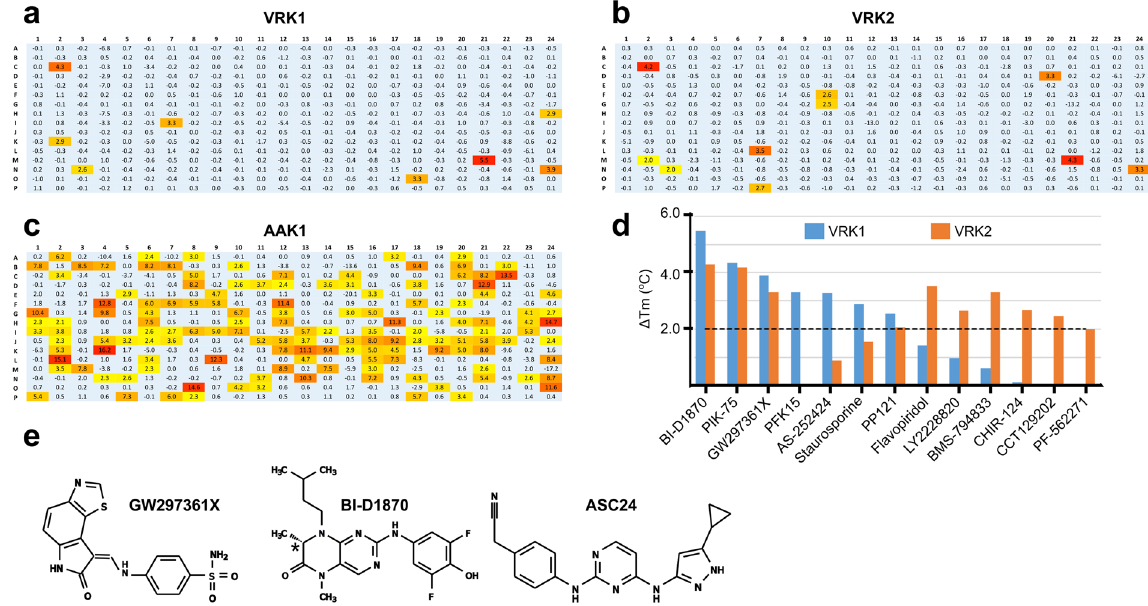
Figure 2. DSF screening identified few hit compounds for active VRKs. Heat maps showing DSF screening data for ( a ) VRK1, ( b ) VRK2 and ( c ) AAK1 (included for comparison) versus a 378-compound library of cell-permeable, bioactive kinase inhibitors. The color scheme is the same as in Fig. 1a. Panels indicate rows (x-axis) and lines (y-axis) in a 384-well plate. Numbers show the observed Δ Tm shift in degrees Celsius. ( d ) Bar graph showing Δ Tm (°C) for top hit compounds for VRK1 (blue bars) and VRK2 (orange bars). ( e ) The three compounds used in crystallization. BI-D1870 was used as a racemic mix; the chiral carbon is marked with a